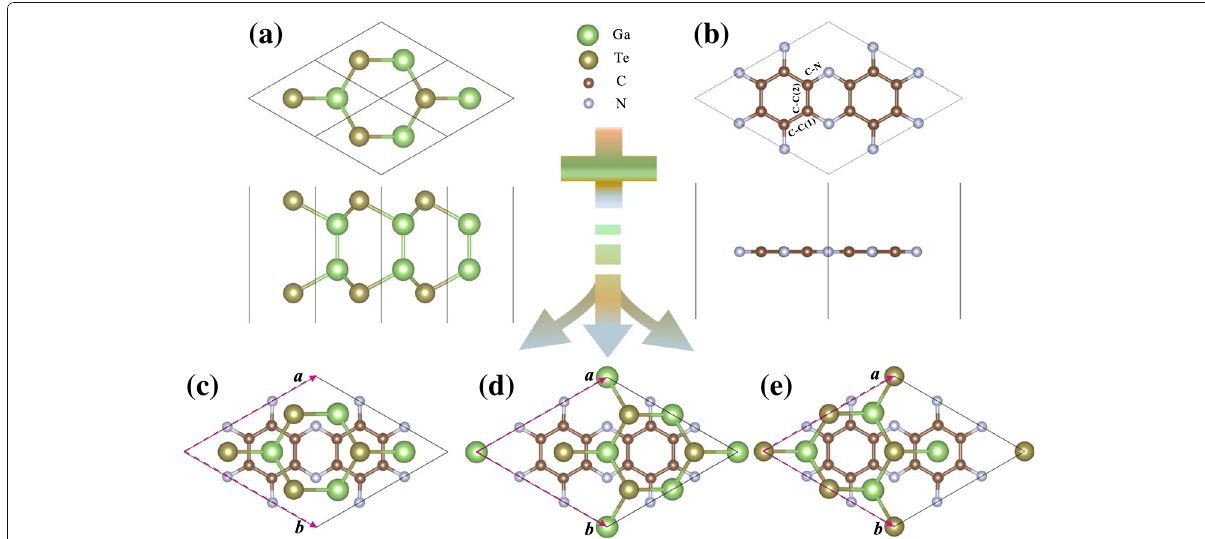
Fig. 1 Top and side views of ( a ) GaTe and ( b ) C 2 N monolayers. Top views of ( c – e ) α -, β -, and γ -stacking GaTe/C 2 N heterostructures, in which the corresponding base vectors of the heterostructures are labeled